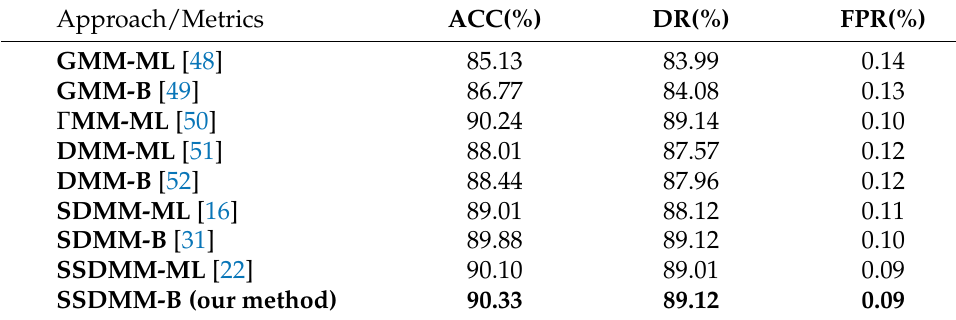
Table 4. Overall accuracy for CXR-Augmented COVID-19